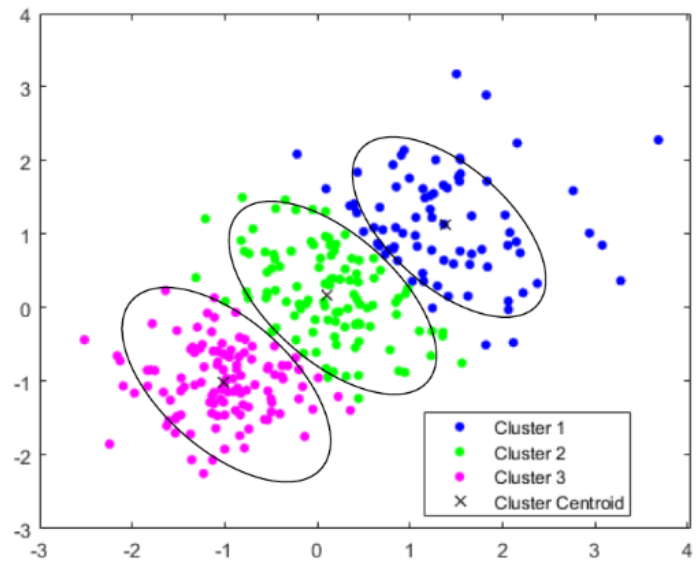
Fig. 4 Wavelet variance in different directions of the urban